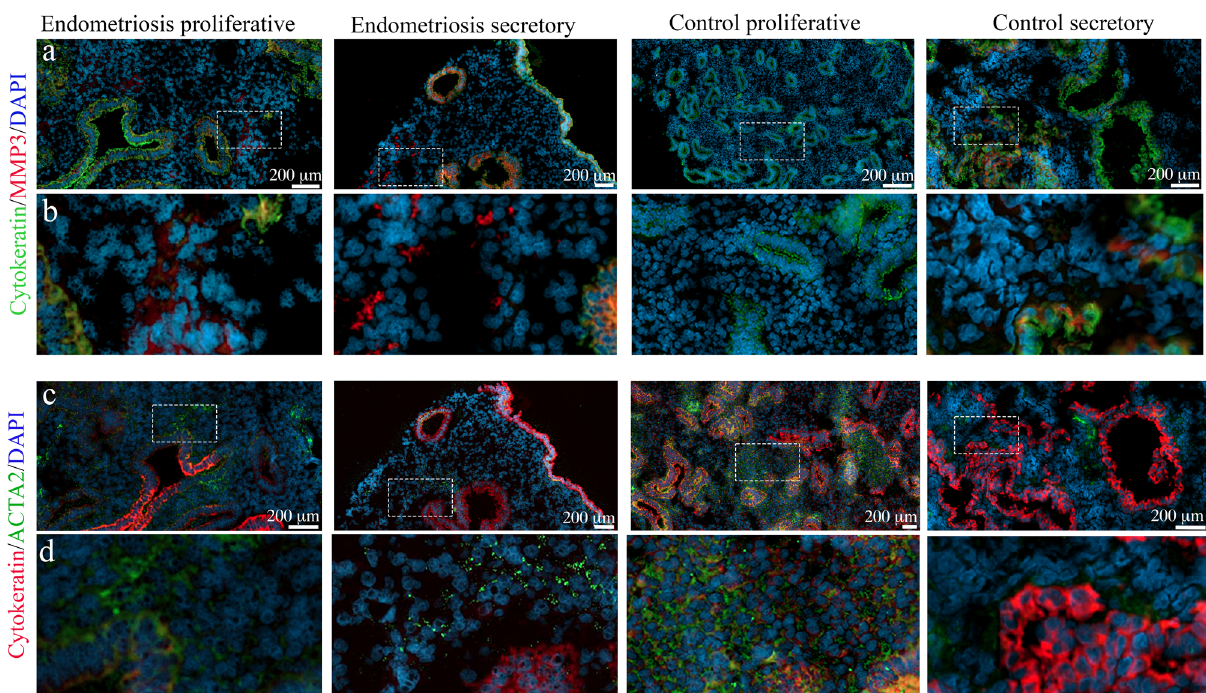
Fig. 6 Protein expression of MMP3 and ACTA2 in the endometrium of women with and without endometriosis. Using MMP3 (Upper panels) and ACTA2 (lower panels) speci fi c antibodies and serial section of endometrium we identi fi ed protein expression of genes upregulated in the fi broblast minor and fi broblast major clusters. a In endometrial tissue of women with and without endometriosis, we used cytokeratin (green) to identify and exclude epithelial cells. MMP3 (red) in the marker for the fi broblast minor cluster was expressed in epithelial cells and a select number of non-epithelial cells. b Inset shows higher magni fi cation. Expression appeared more common in endometriosis patients compared to controls. The increased expression also appeared in the secretory stage of both endometriosis patients and controls compared to the proliferative stage. c Endometrial tissue of women with and without endometriosis also expressed ACTA2 (green), a marker for the fi broblast major cluster. Samples were also incubated with cytokeratin (red) to identify epithelial cells. Expression was detected in both epithelial (red) and non-epithelial cells. d Expression of ACTA was widespread across non- epithelial cells in both women with and without endometriosis and appeared stronger in samples derived from the proliferative